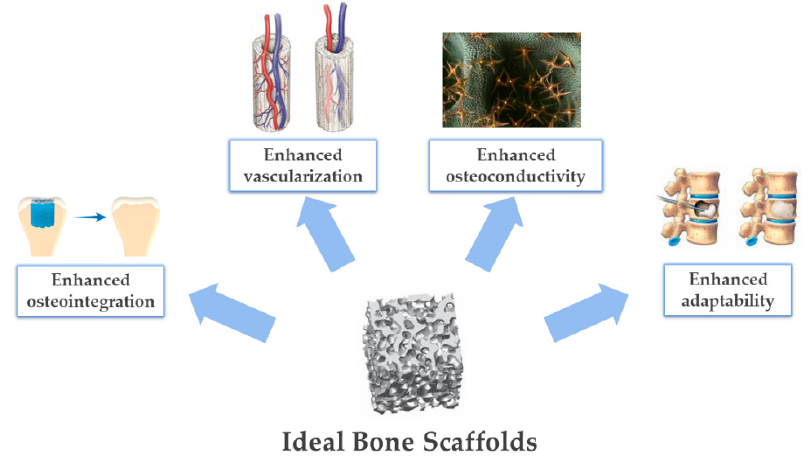
Figure 2. Relevant challenges in the development of biomimetic scaffolds for bone regeneration.